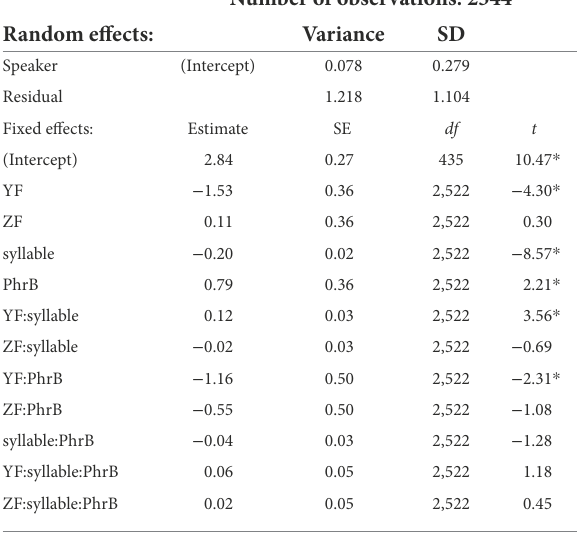
TABLE 2 LMM analysis on downstep size (difference of maximum F0 between LH and HH sentences in the H tones) with the equation